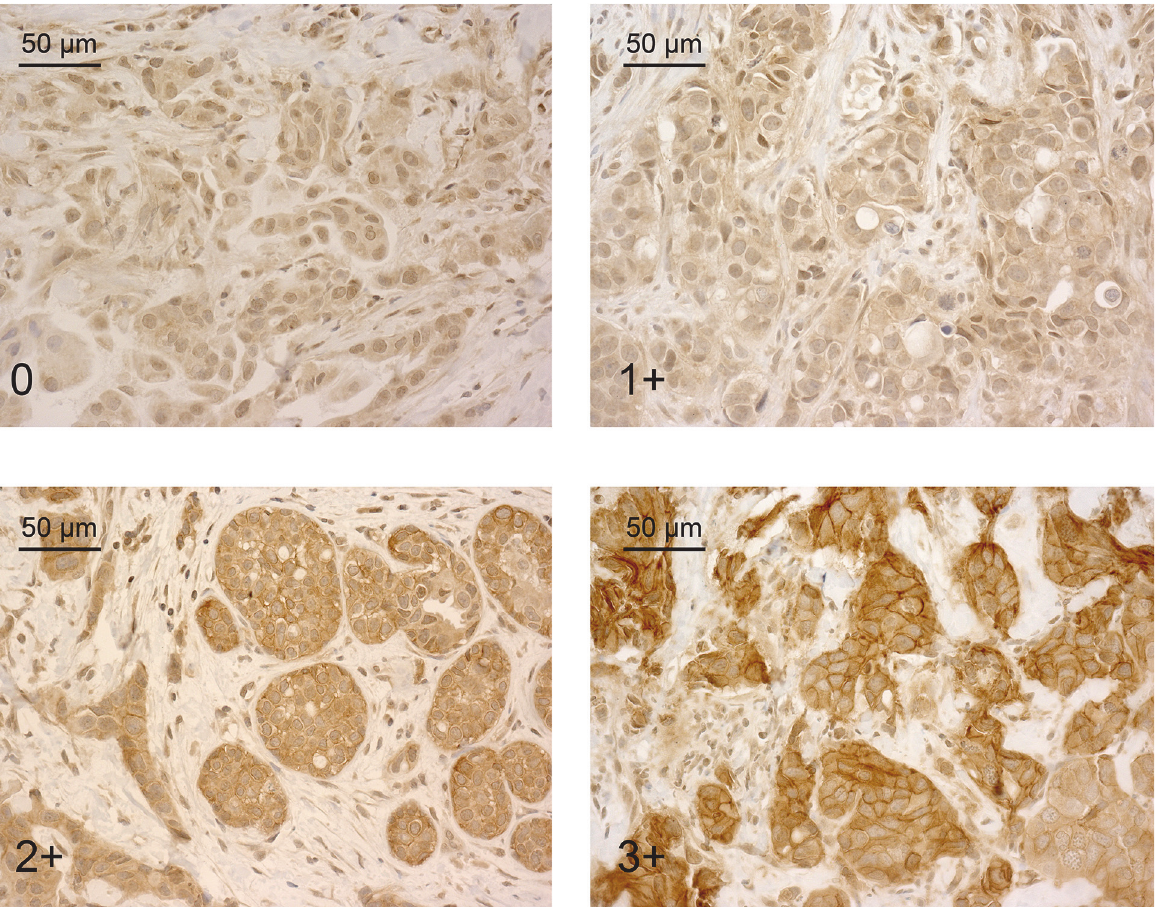
Fig 1. Examples of IGF-1R immunostaining of breast tumors. Scoring of IGF-1R membrane expression is depicted in the lower left corner. Magnification 400X, DAB staining.